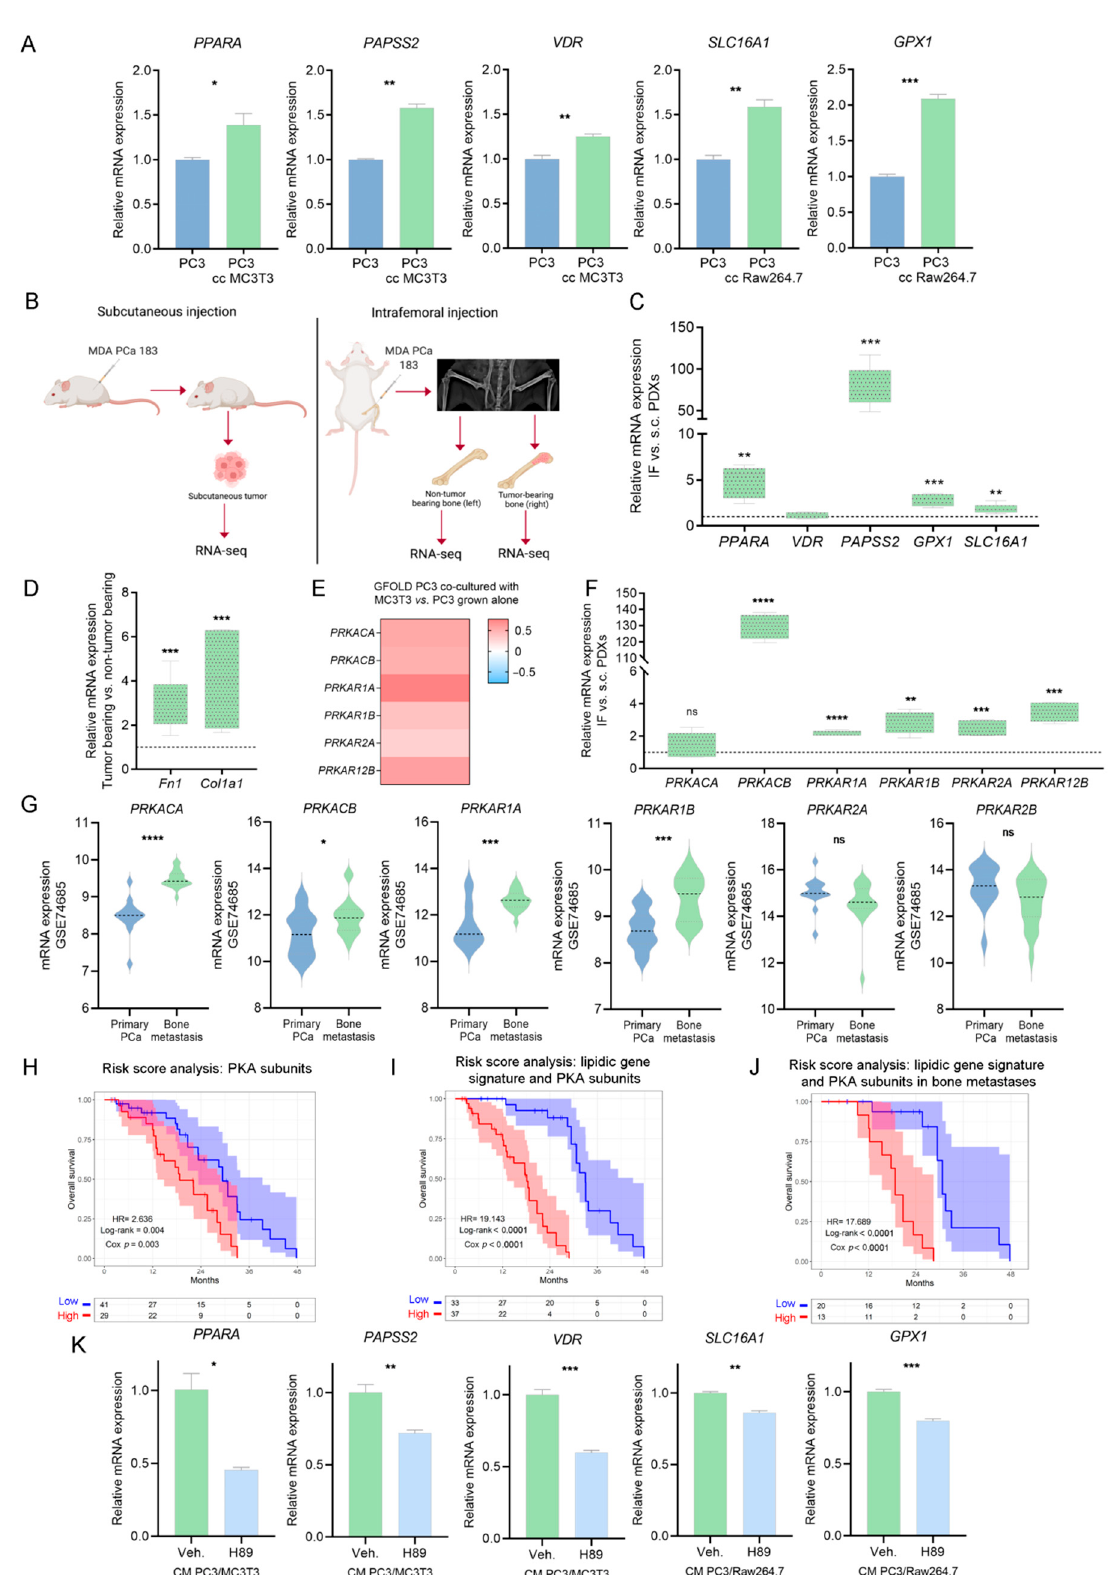
Figure 6. Role of PKA in the metabolic phenotype of co-cultured PC3 cells. ( A ) Gene expression validation of the lipid-associated gene signature by RT-qPCR in PC3 grown alone (PC3; control) and in PC3 co-cultured with MC3T3 or Raw264.7 cells (PC3 cc MC3T3 and PC3 cc Raw264.7, respec-tively). The values were normalized using PPIA as a reference gene and relativized to the controls.